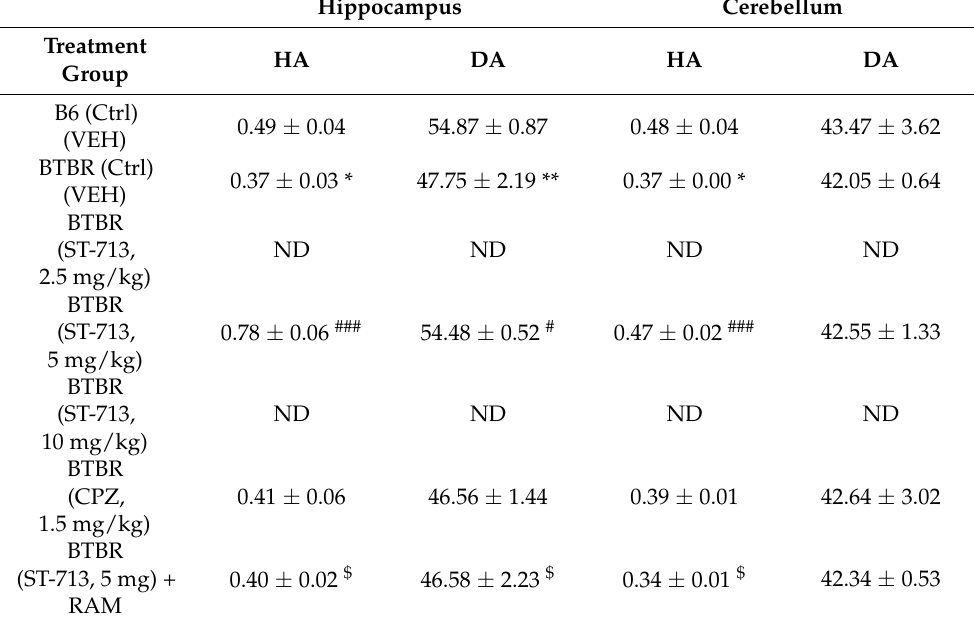
Table 2. ST-713 modulated levels of hippocampal and cerebellar HA and DA in BTBR mice. Hippocampus